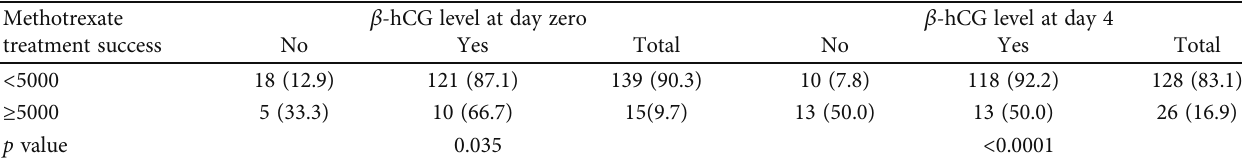
Table 4: Association of β -hCG values on days 0 and 4 in relation to methotrexate treatment success.